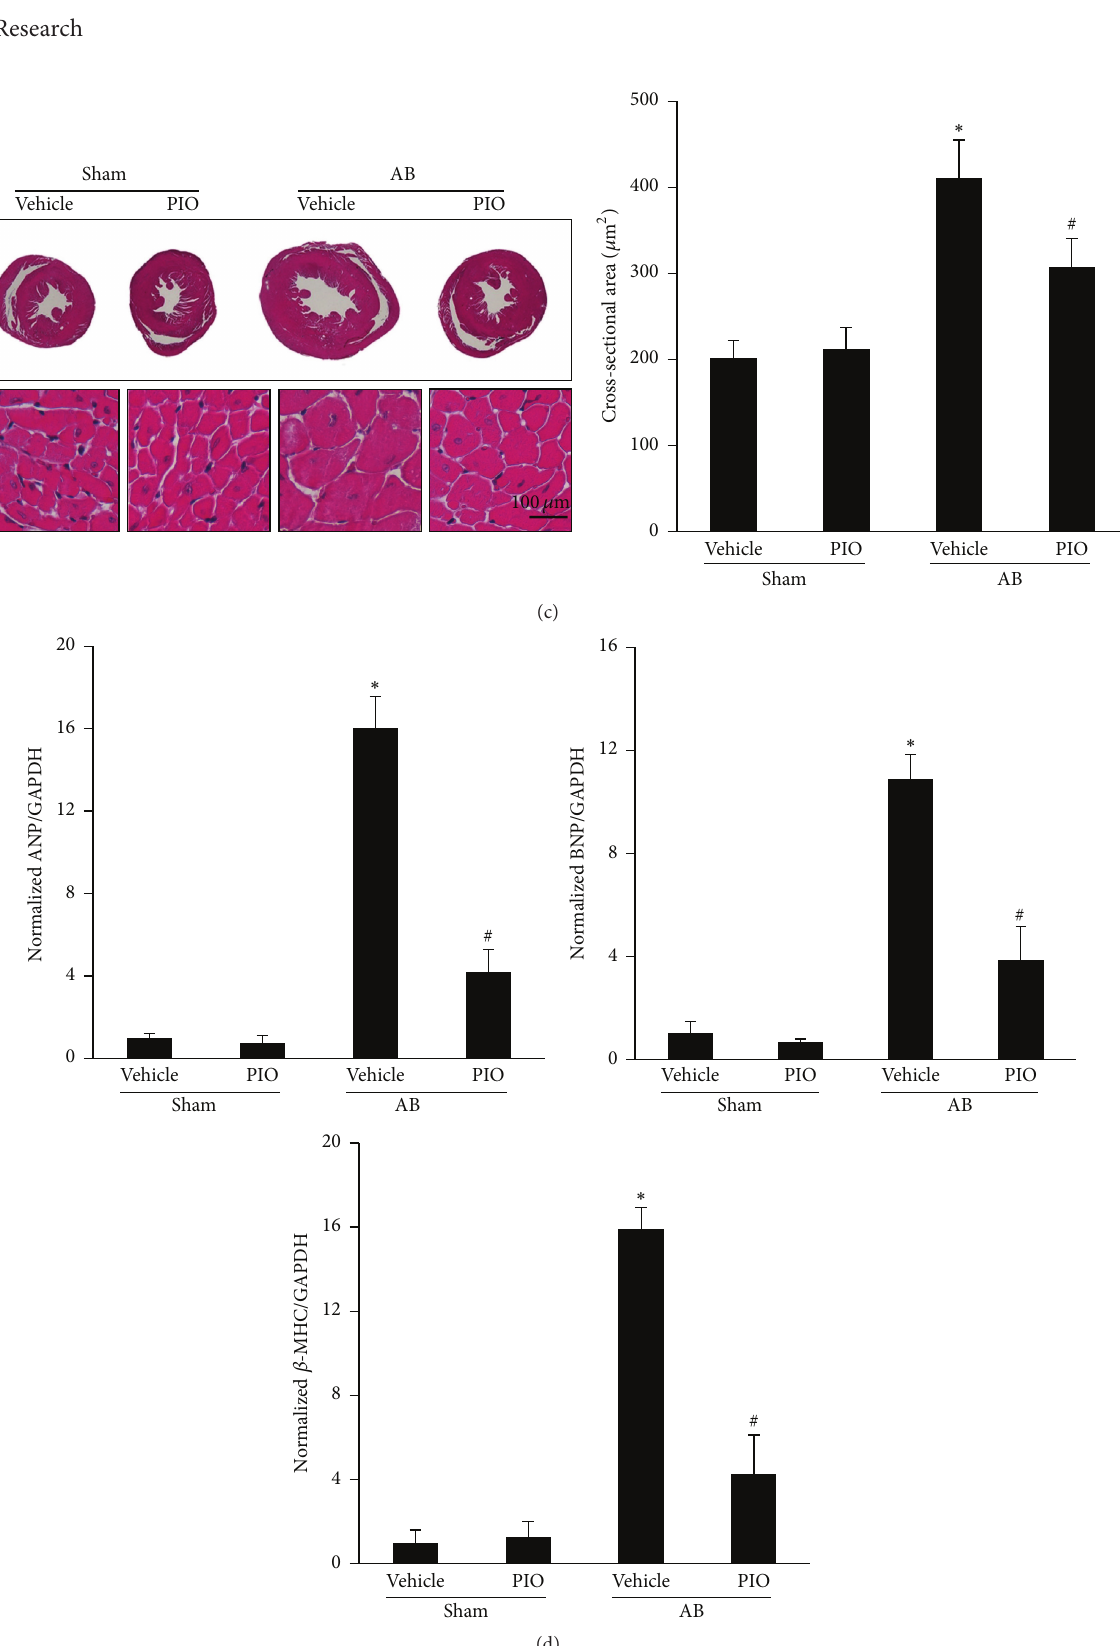
Figure 1: PIO inhibited cardiac hypertrophy in vivo. (a) Echocardiography results of LVDD, LVEF, and LVFS of the indicated groups ( 𝑛 = 10 – 12). (b) Results of the HW/BW, HW/TL ratios of the indicated groups ( 𝑛 = 13 –15). (c) Gross hearts, HE staining, and cross-sectional area after 8 weeks of AB or sham with or without PIO ( 𝑛 = 4 ). (d) Expression levels of the transcripts for ANP, BNP, and 𝛽 -MHC normalized by GAPDH of the indicated groups ( 𝑛 = 4 ). ∗ 𝑃 < 0.05 as compared with the corresponding sham group. # 𝑃 < 0.05 versus the AB